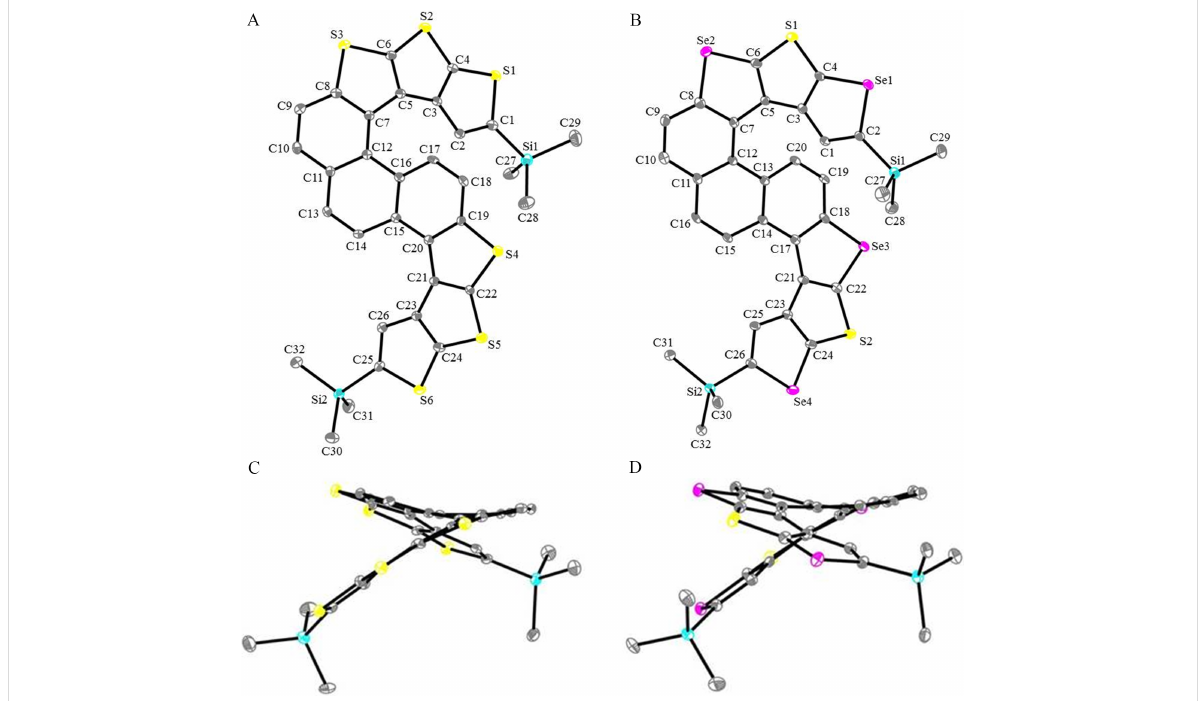
Figure 3: Molecular structures and side view for DH - 1 and DH - 2 . A and B are molecular structures for DH - 1 and DH - 2 . C and D are side views for DH - 1 and DH - 2 . Carbon, sulfur, selenium, and silicon atoms are depicted with thermal ellipsoids set at the 30% probability level and all hydrogen atoms are omitted for clarity.